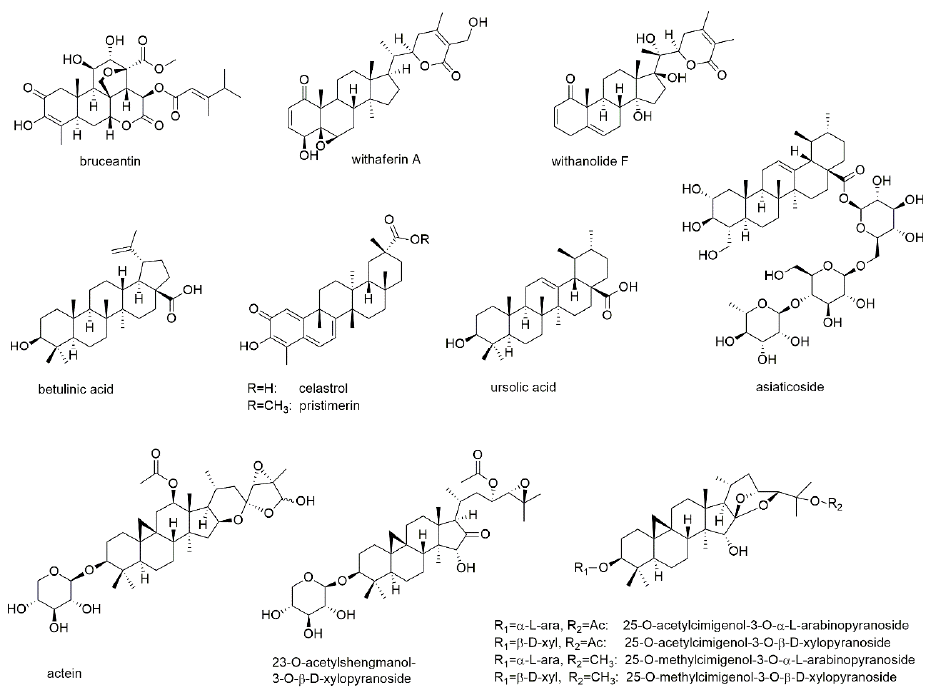
Figure 13. Triterpenes with reported activity against myeloma cell lines.